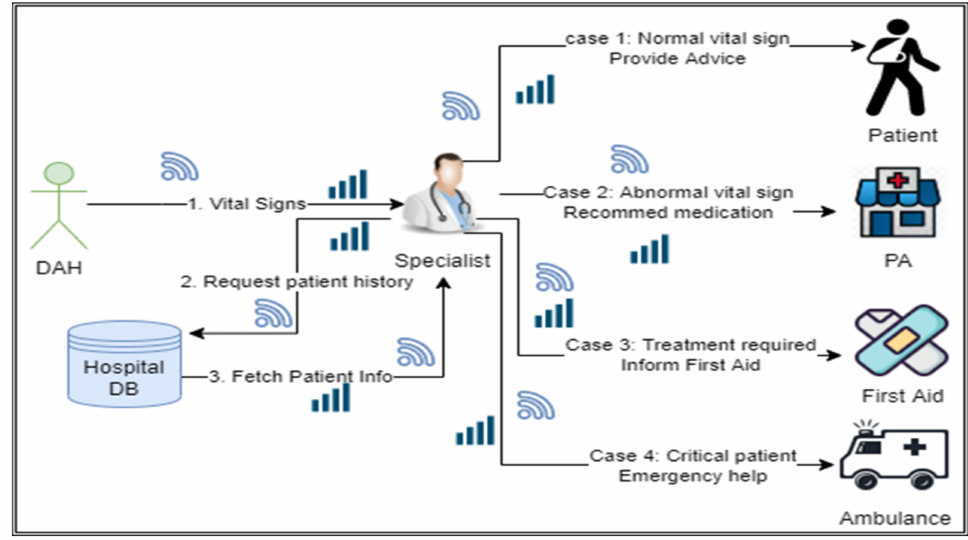
Figure 5. Role of the specialist in providing healthcare facilities.